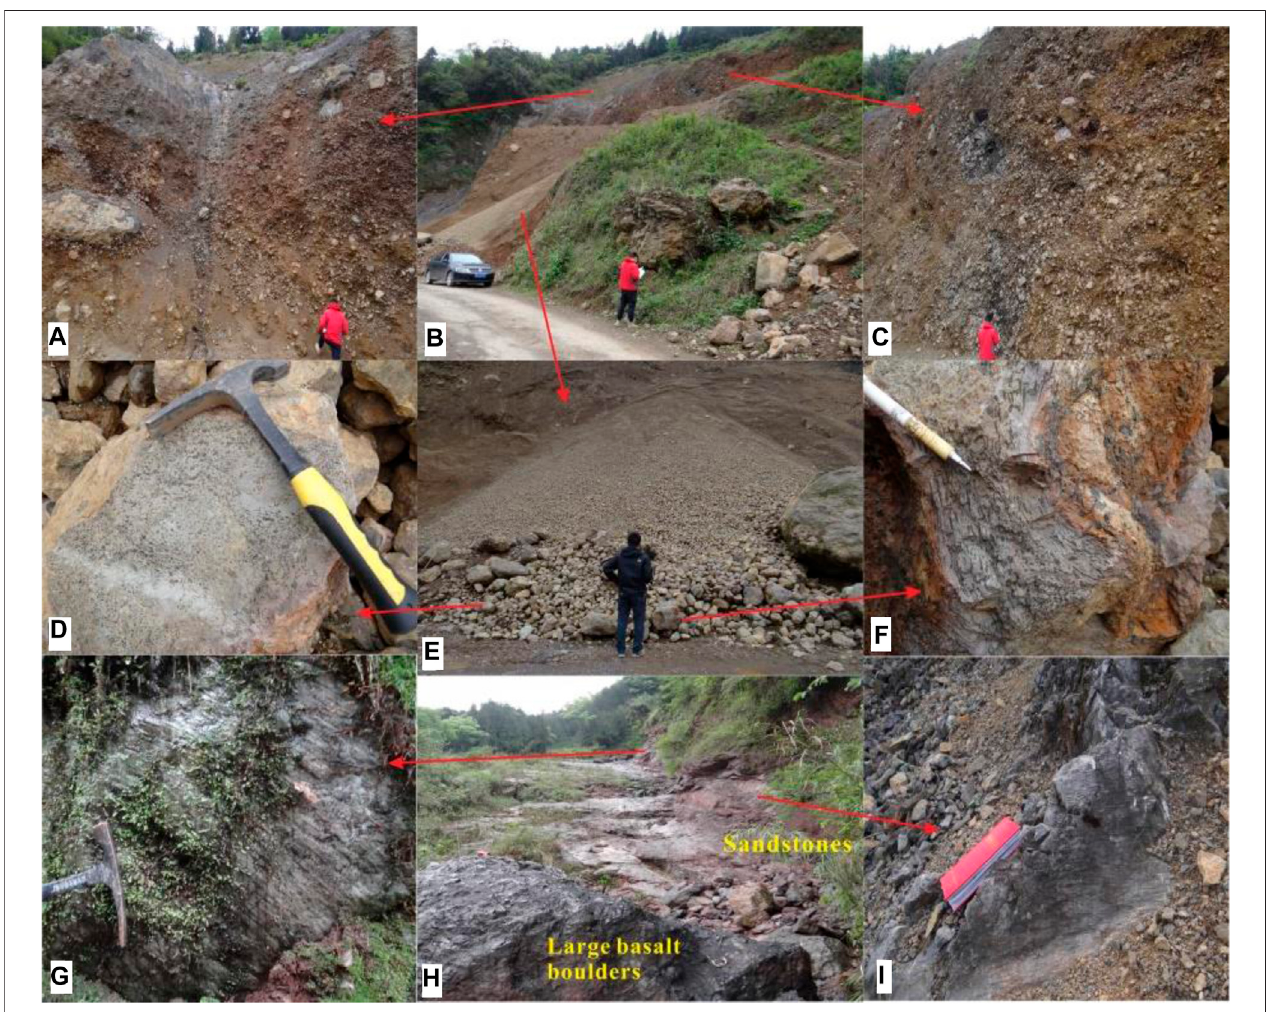
FIGURE 7 | The deposits and the bedrock after scraping are distributed in the landslide transportation area. (B) Landslide deposits at observation point D033. (A,C) There are many larger basaltic boulders in the upper part of landslide accumulation. (E) The material composition of the lower part of the landslide accumulation body is mainly composed of fi ne particles such as gravel and breccia. (D,F) The basaltic stones were mainly amygdaloidal and some show severe argillization. (H) Bedrock is exposed near survey point D015. (G,I) Scratches can be seen on the rock mass surface.